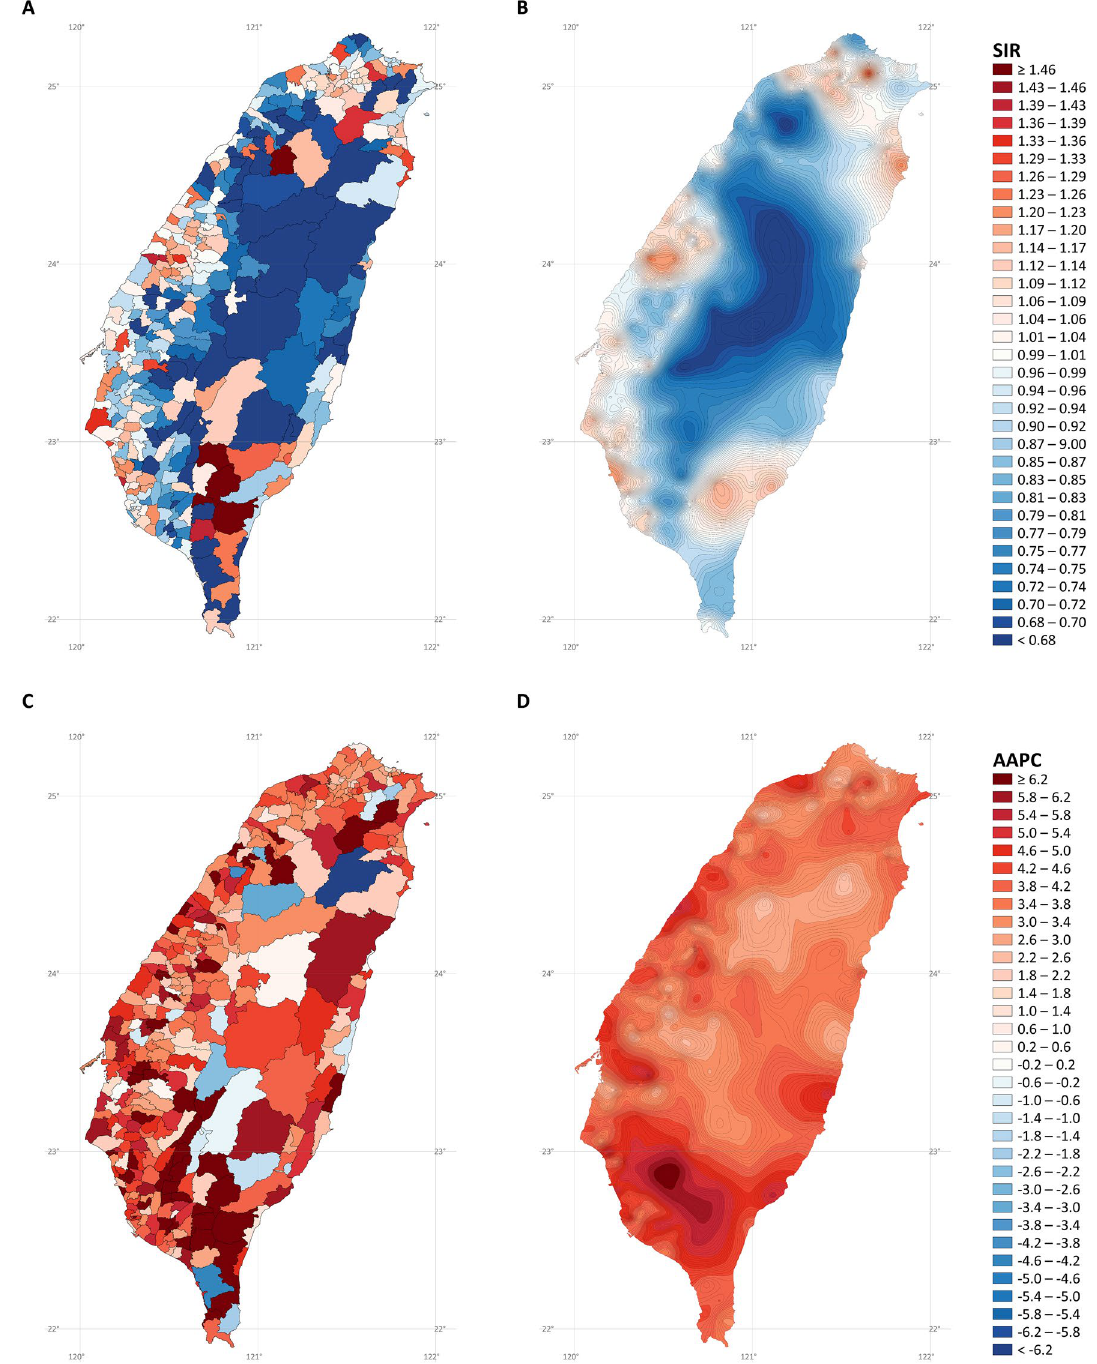
Figure 6. Maps of lung adenocarcinoma cancer in males ( A) standardized incidence ratios; ( B) stabilized kriged standardized incidence ratios; ( C) average annual percent changes; ( D) stabilized kriged average annual percent changes). The map was created by R version 3.5.2 with the ggplot2 package (https:// cran.r- proje ct. org/ web/ packa ges/ ggplo t2/ index.